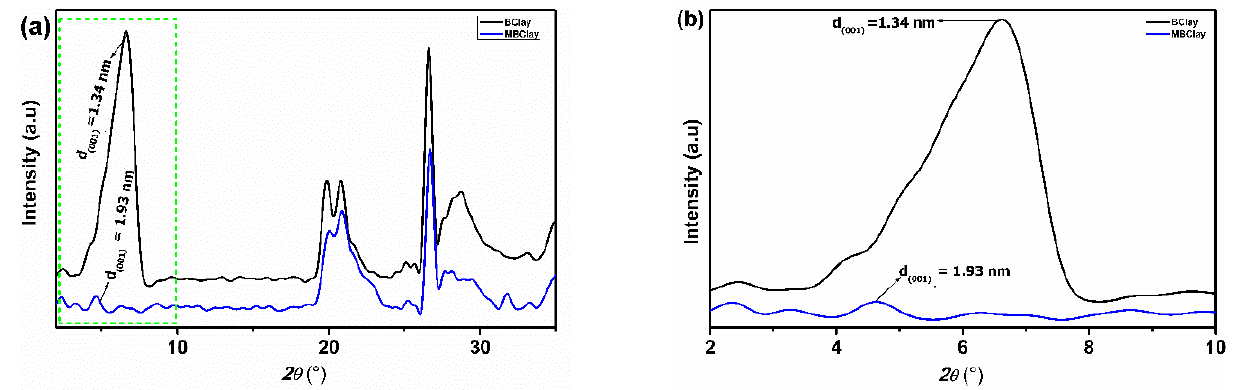
Figure 1. ( a ) XRD patterns of natural and modified BClay in the 2 θ range from 2 to 35°; ( b ) ex- panded view of the XRD patterns in the 2 θ range from 2 to